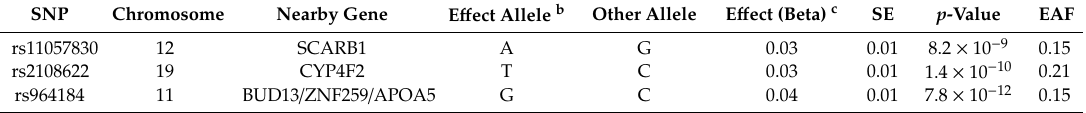
Table 1. Characteristics of three SNPs in previously published vitamin E GWAS data set a .